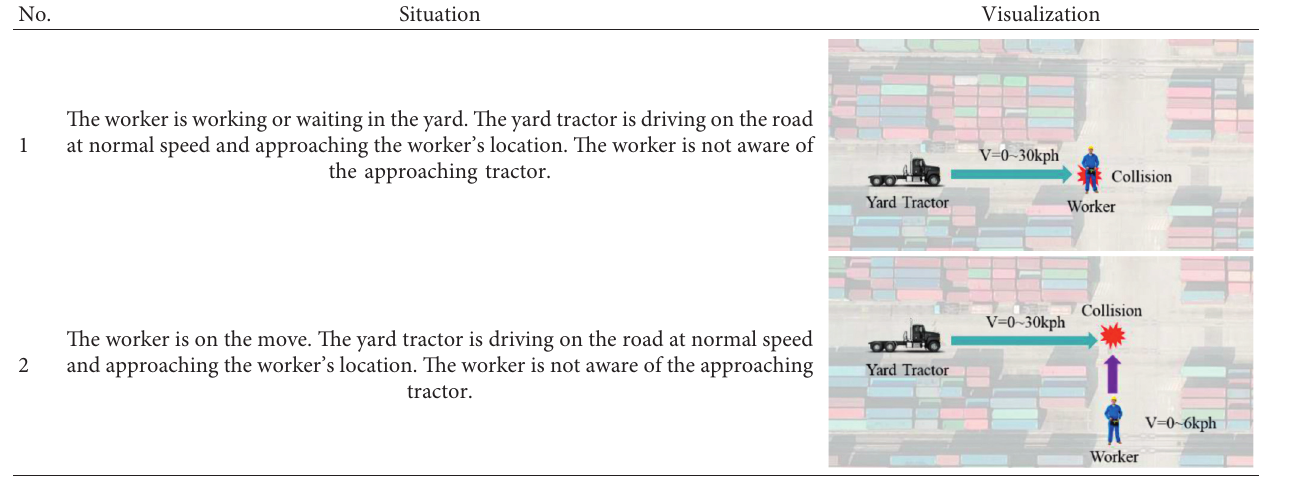
Table 1: Examples of collision-risk situations between pedestrian and